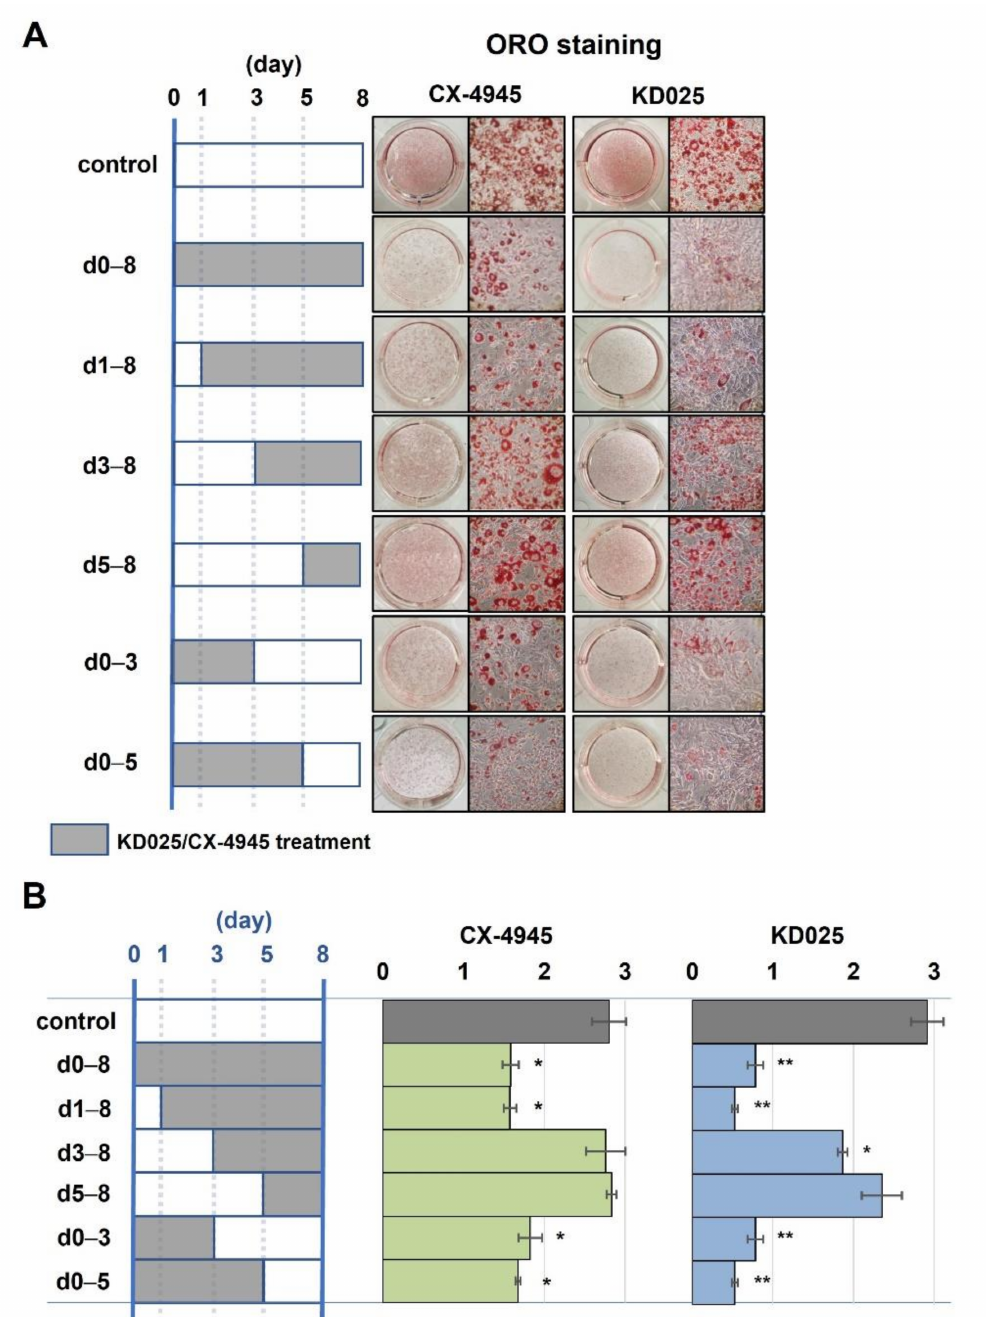
Figure 6. Parallel comparison of stage-specific effect between CX-4945 and KD025 on the adipogenesis of 3T3-L1 cells. 3T3-L1 cells were treated CX-4945 (5 µ M) or KD025 (3 µ M) at various times as indicated by grey bar during differentiation. At day 8, cells were stained with ORO. ( A ) Microscopic images were taken, and ( B ) lipid accumulation was assessed by obtaining absorbance at 540 nm. * p < 0.05; ** p < 0.01 vs.